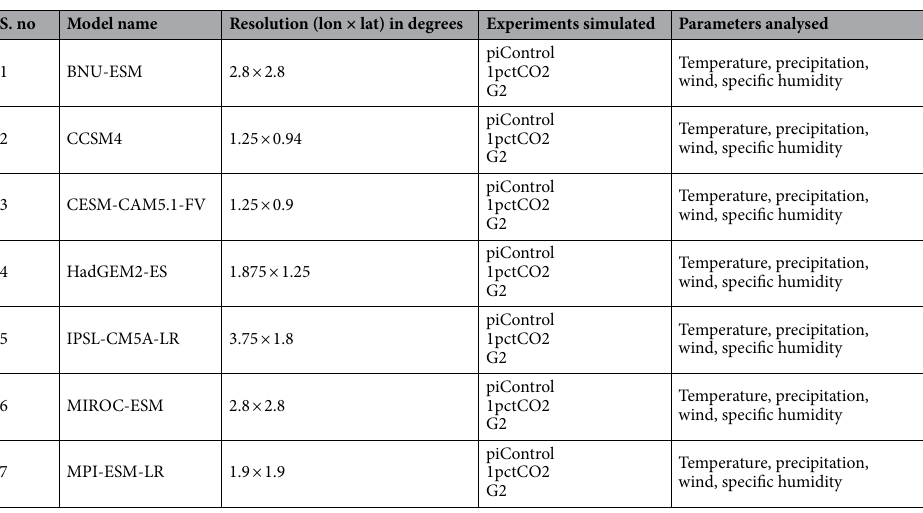
Table1. List of the Earth System Models used in this study and their